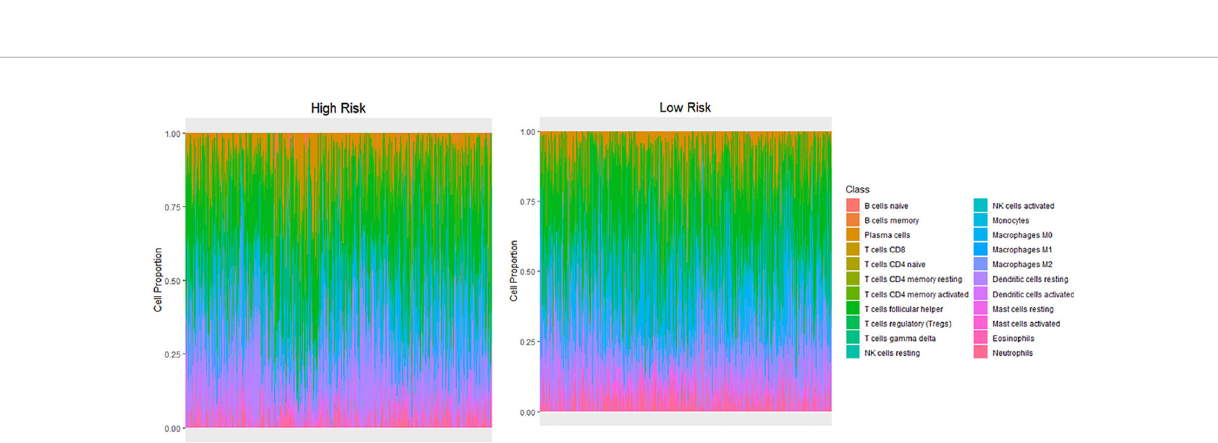
FIGURE 6 | Differences in in fi ltration of different immune cell types between the high- and low-risk